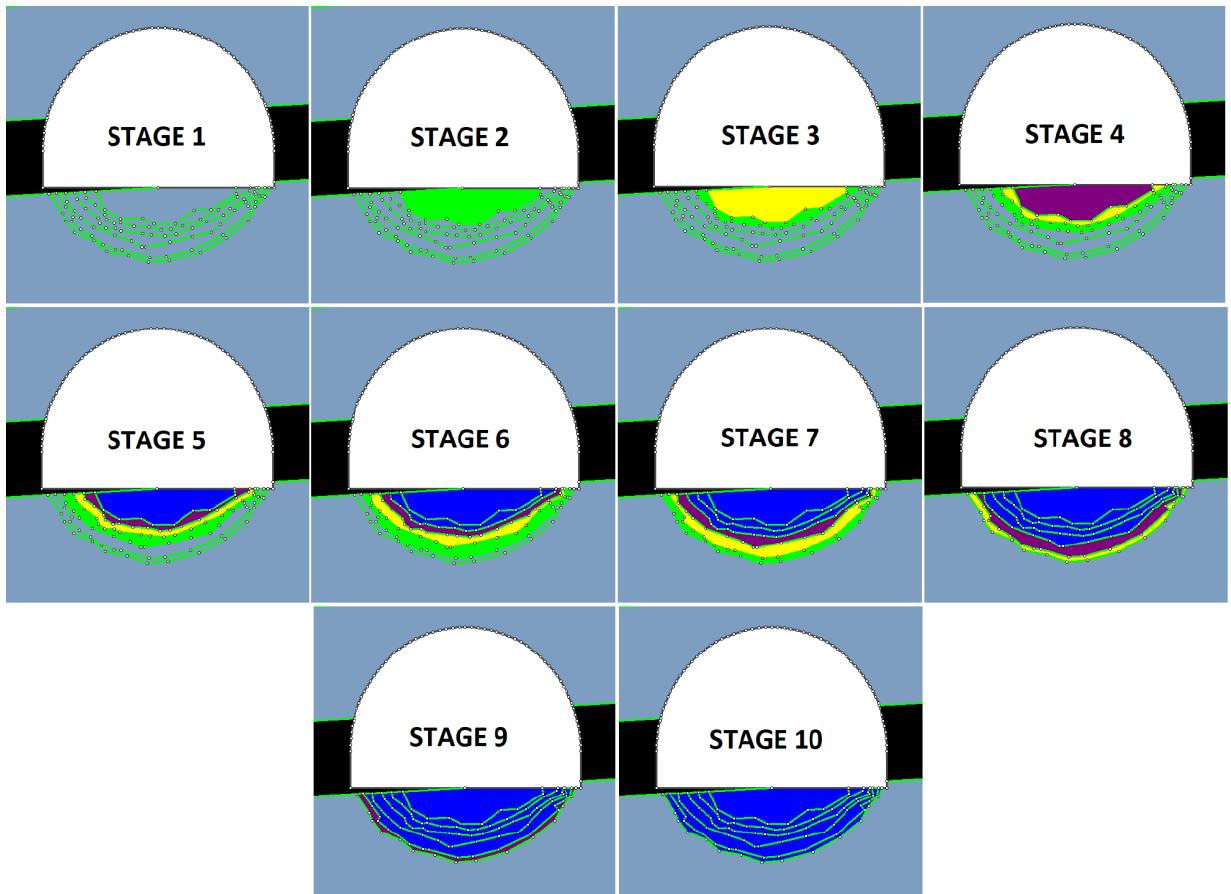
Figure 30. Stages of the numerical simulation of the impact of saturation of the rocks beneath the floor of roadway F-33 on the magnitude of the floor heave, and with various geomechanical properties: gray color — dry rocks, green — rocks after 3 h of soaking with water, yellow — rocks after 6 h of soaking, purple — rocks after 12 h of soaking, dark blue — rocks after 24 h of soaking. Table 8. Comparison of the convergence results from numerical model of roadway F-33 with the in situ measurements on the 415th meter of the roadway.